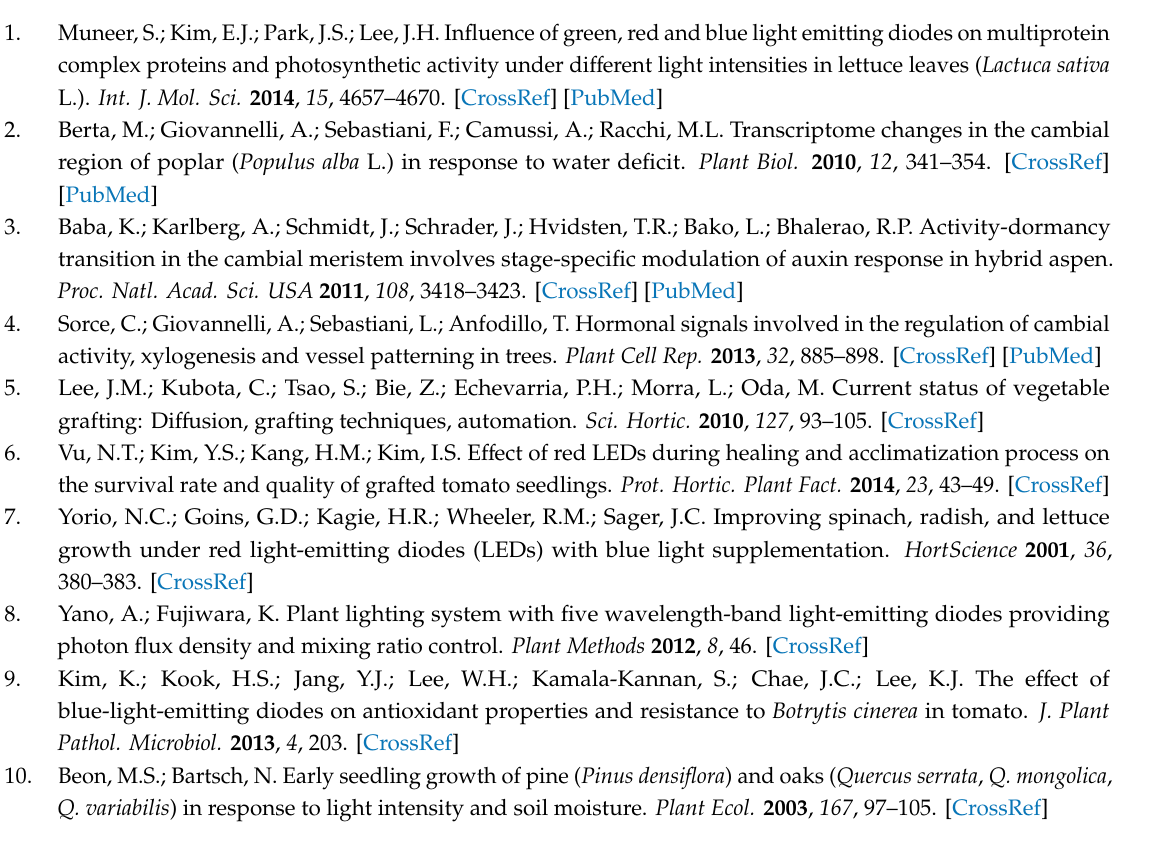
Table S1: Sequences of Primers used in the expressions of photosynthesis-related